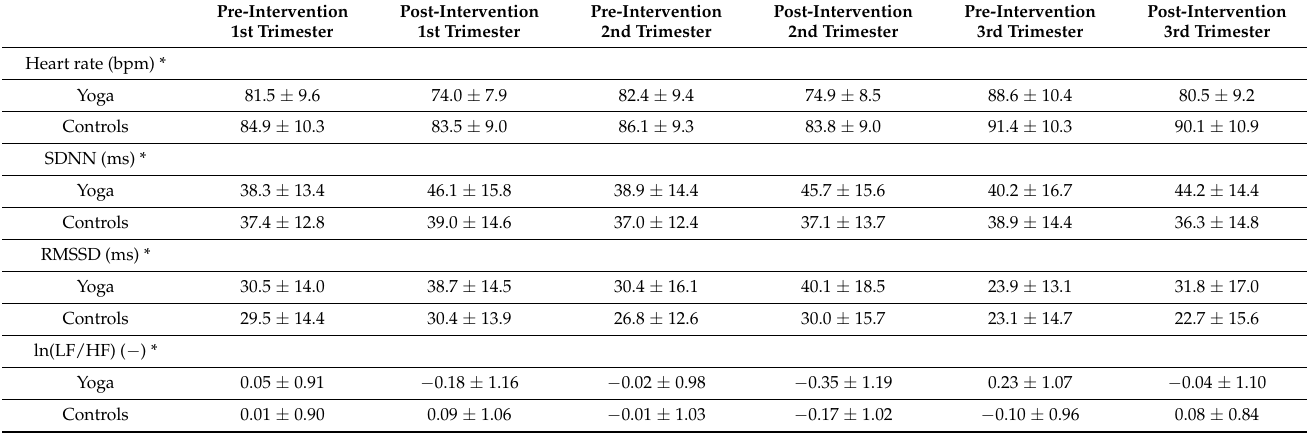
Table 2. Heart rate variability variables before vs. after yoga practice (yoga group) or walking (control group) throughout